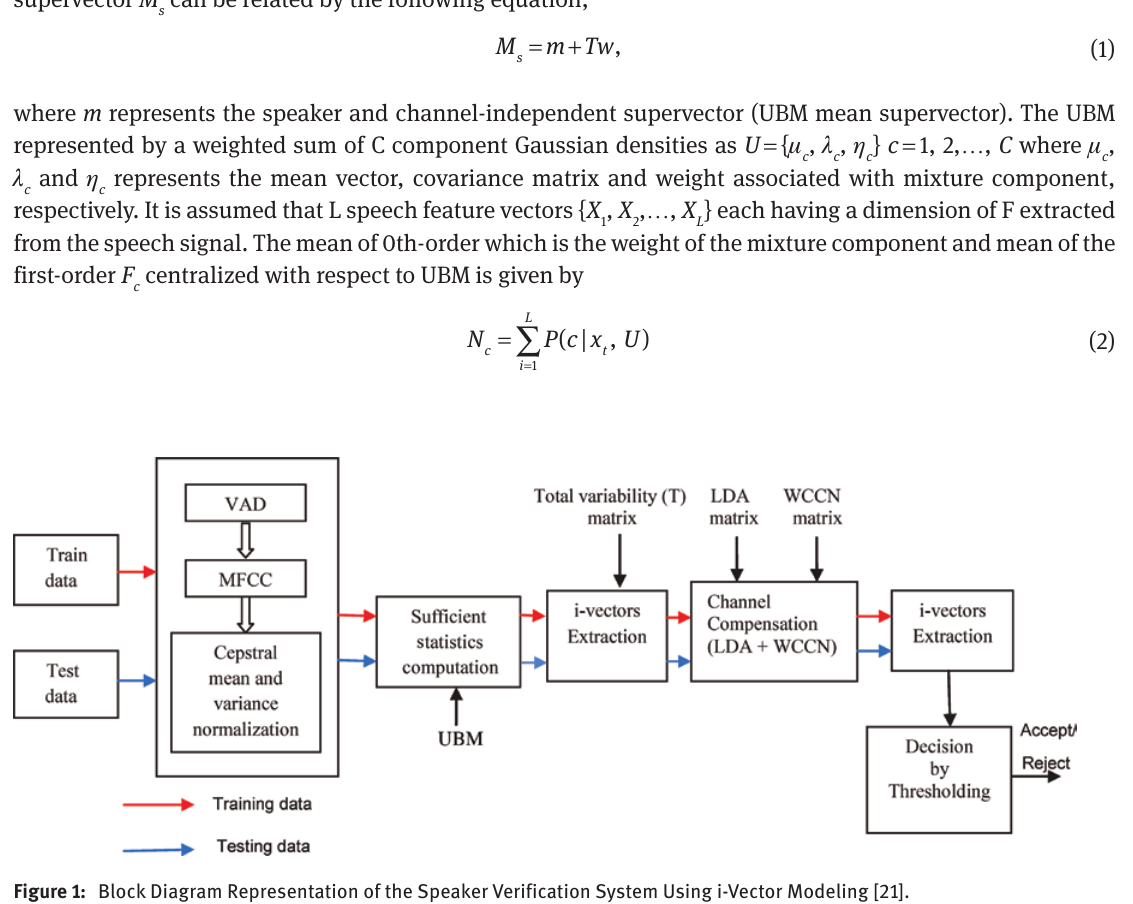
Figure 1: Block Diagram Representation of the Speaker Verification System Using i-Vector Modeling